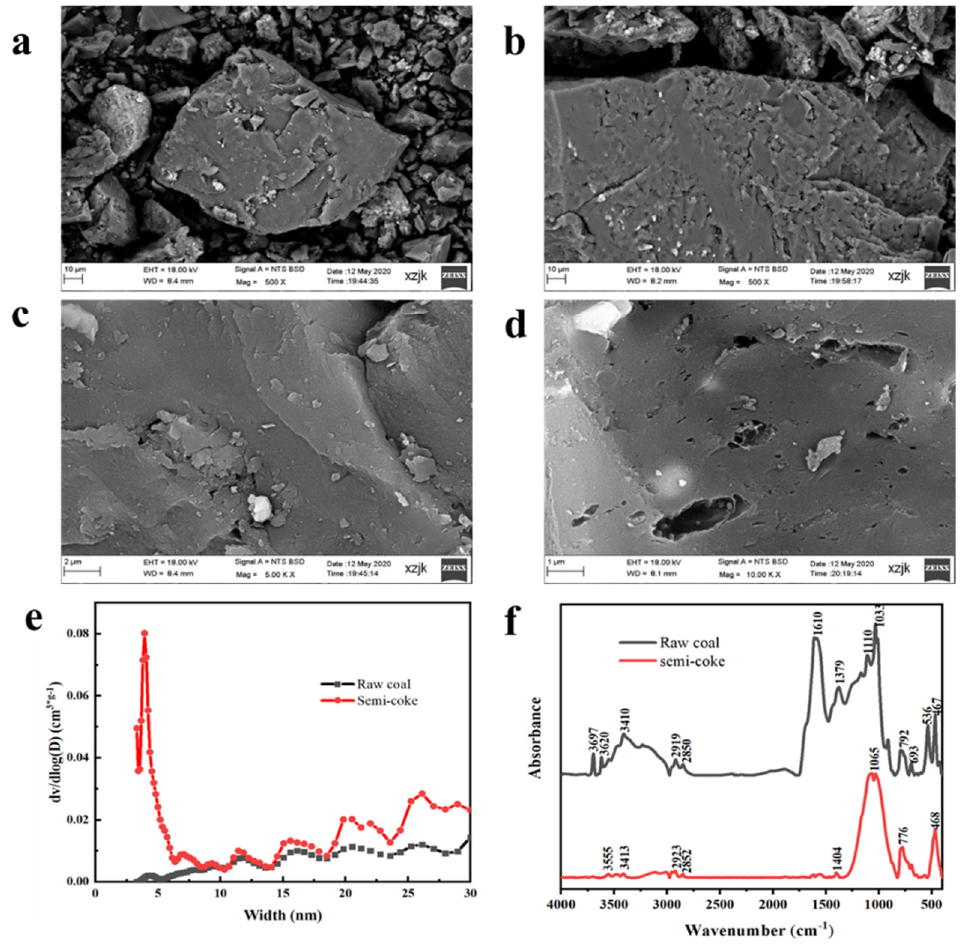
Figure 1. SEM images of the raw coal ( a , c ) and the SC ( b , d ); the pore size distribution of raw coal and SC ( e ); FTIR spectra of raw coal and SC ( f ).